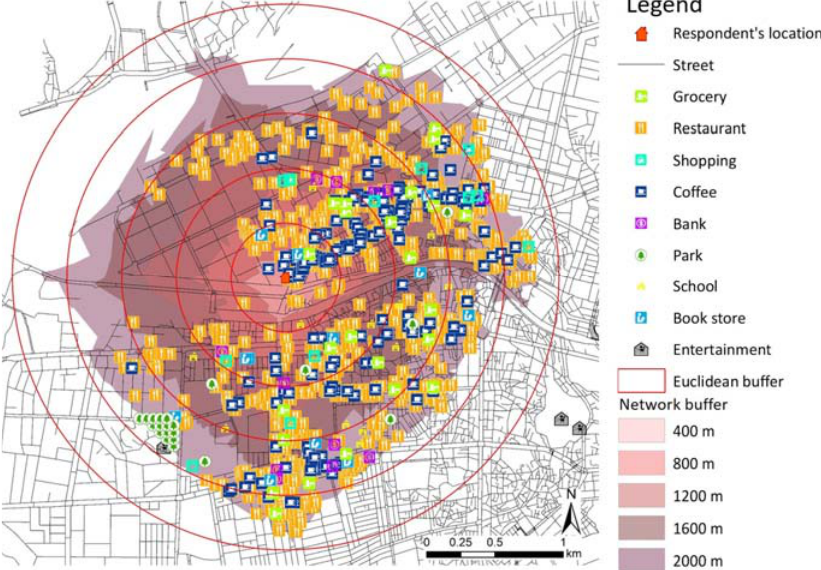
Figure 2. Nine types of amenities within walking distance from the respondent’s location.